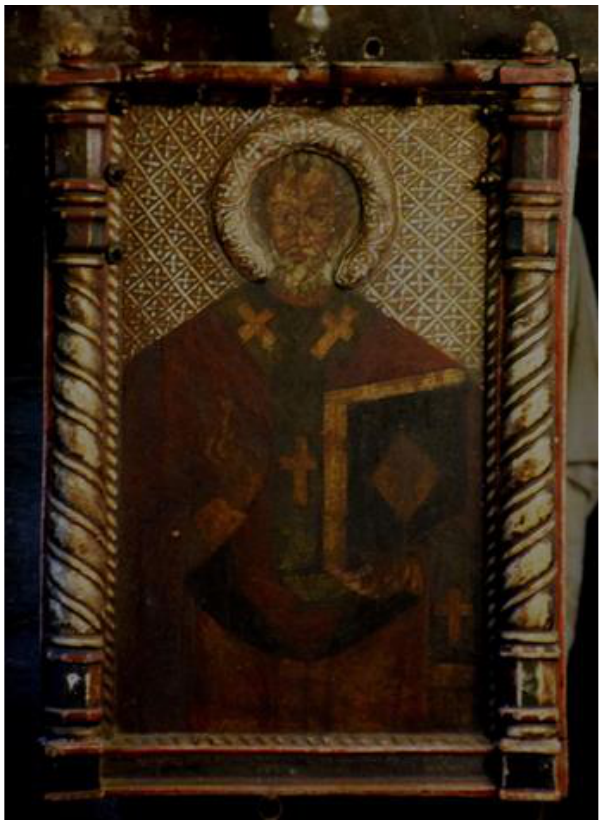
Figure 4. The icon of Saint Nicholas of Myra in the orthodox church in Păușa, Romania.